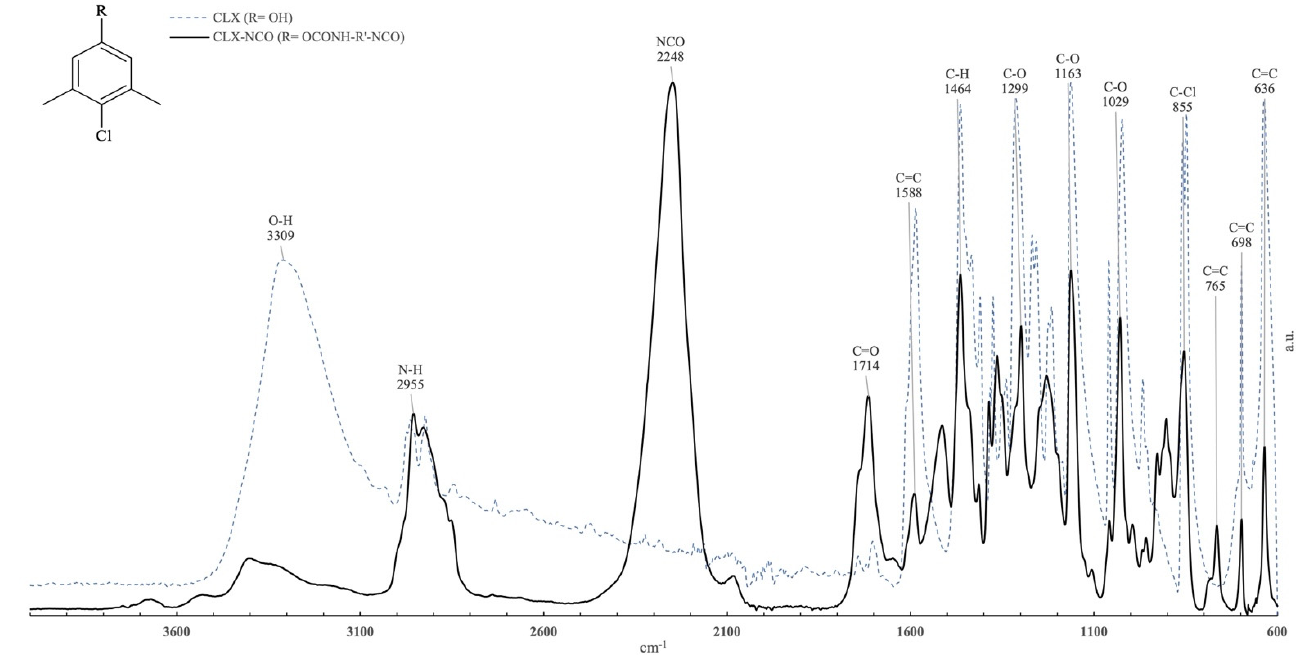
Figure 1. Normalized absorbance infrared spectra (FTIR-ATR) obtained from Chloroxylenol (dashed-line blue, R = OH), and its isocyanate functional derivative (solid line, R = OCONH–R ′ –NCO, C–NCO).